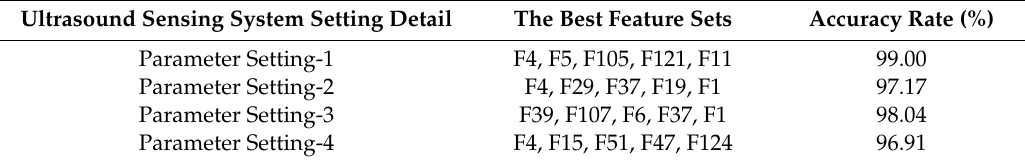
Table 15. Classification results of the SVM-enabled intelligent genetic algorithmic model when it chooses five features in each parameter